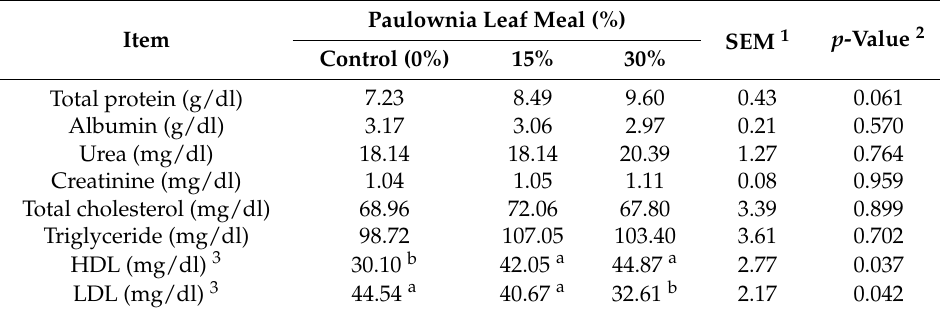
Table 6. Effects of paulownia leaf meal on the blood chemistry of growing New Zealand White rabbits at 13 weeks of